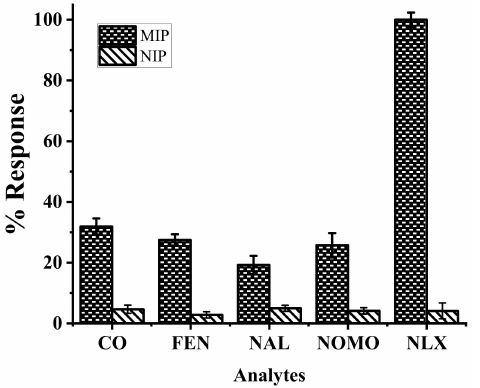
Figure 6. Percent current response of sol-gel MIP and sol-gel NIP modified fMWCNT/ITO sensors towards 12 mM NLX and its structural analogues. Error bars represent standard deviation of three independent measurements.